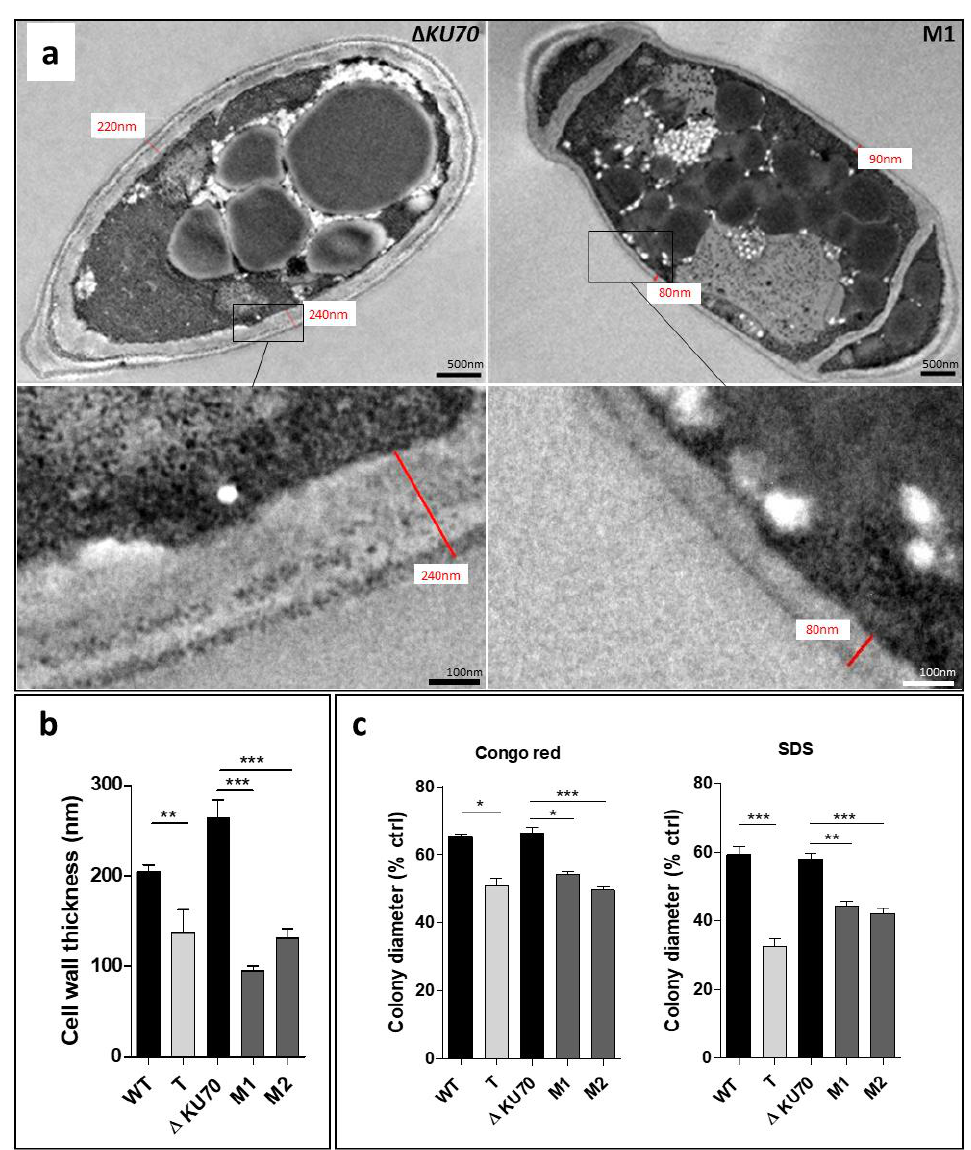
Figure 5. Evaluation of cell-wall thickness and integrity. ( a ) TEM of Δ KU70 and M1 conidia cell walls. The image is representative of the three transformants. ( b ) Thickness determined from transmission electron microscopy (TEM) acquisition for 20 acquisitions. ( c ) Growth in contact with the cell-wall chemical stressors Congo Red and SDS. After an incubation of seven days at 30 °C, the colony diameter was measured and expressed according to the control growth on stress-free PDA. All graphs include results obtained from three independent experiments. Significant differences are indicated: * p < 0.05, ** p < 0.01, *** p < 0.001 (Kruskall-Wallis test). T: transformant derived from the WT strain; M1 and M2: transformants derived from the Δ KU70 strain.